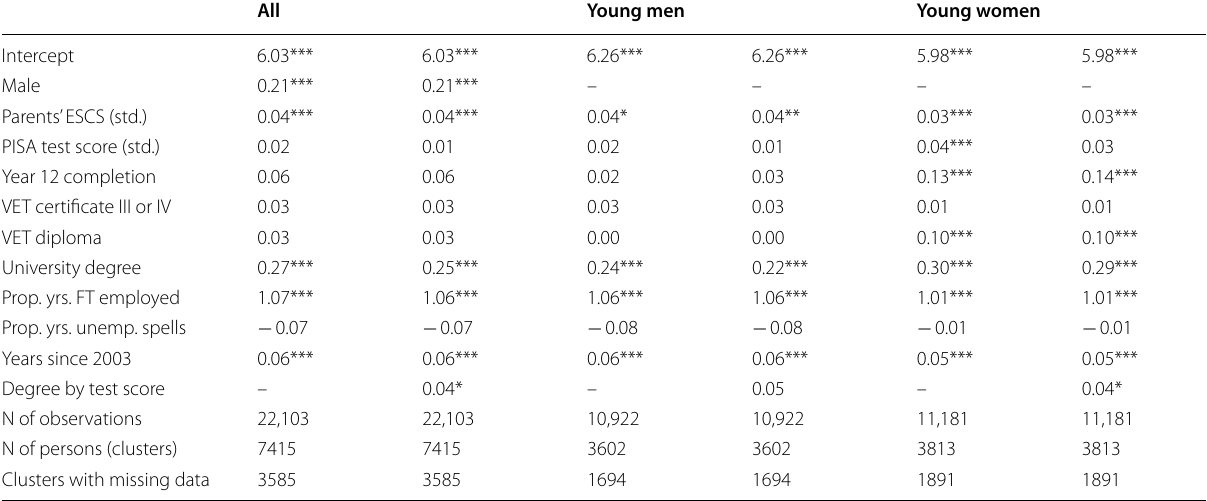
Logged regression coefficients from repeated design analyses. Full-time study observations excluded. Weighted for sample selection and attrition. See Table 1 for abbreviations